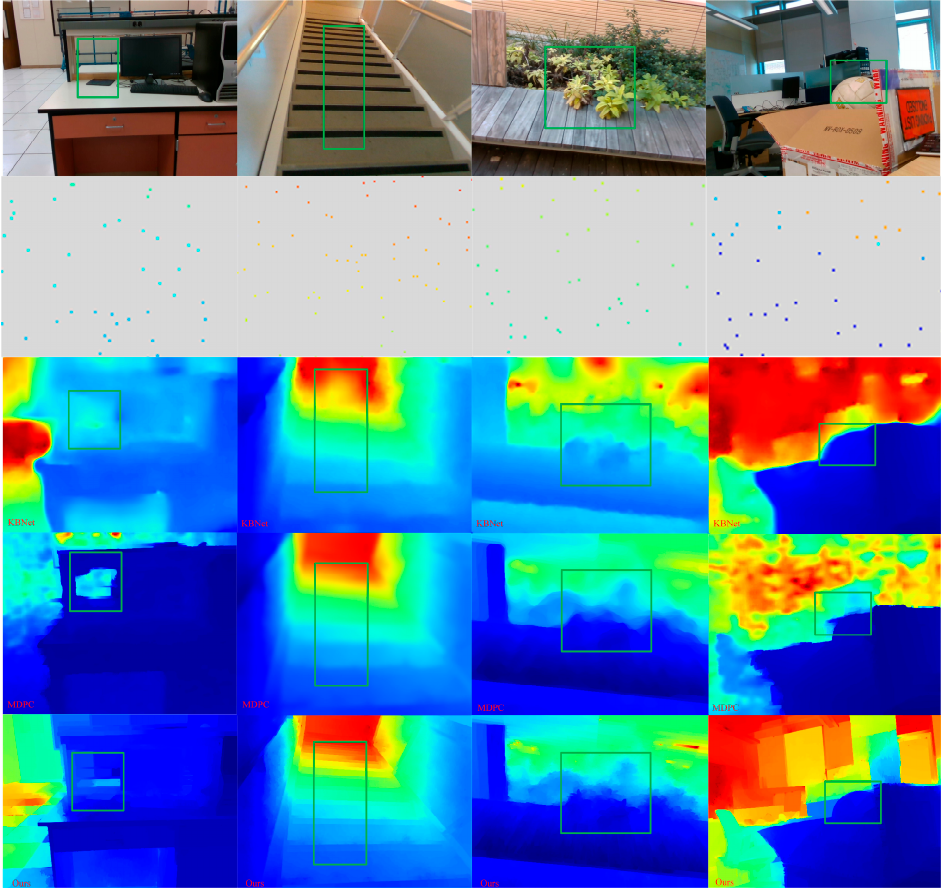
Figure 7. Qualitative results on the KITTI test set. Head-to-head comparison against [9,32]. Our method is smoother and more consistent in terms of edge sharpness and level of detail. Note that the sparse depth images are enlarged for visualization and only the areas highlighted in green are shown.